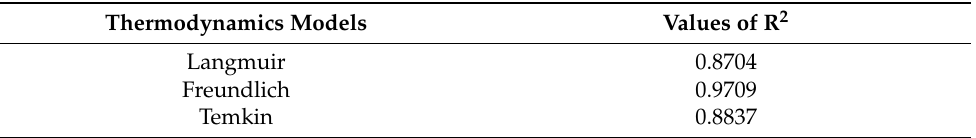
Table 11. The R 2 values of the thermodynamics for carmine adsorption onto rGO/Fe/Cu nanohy-